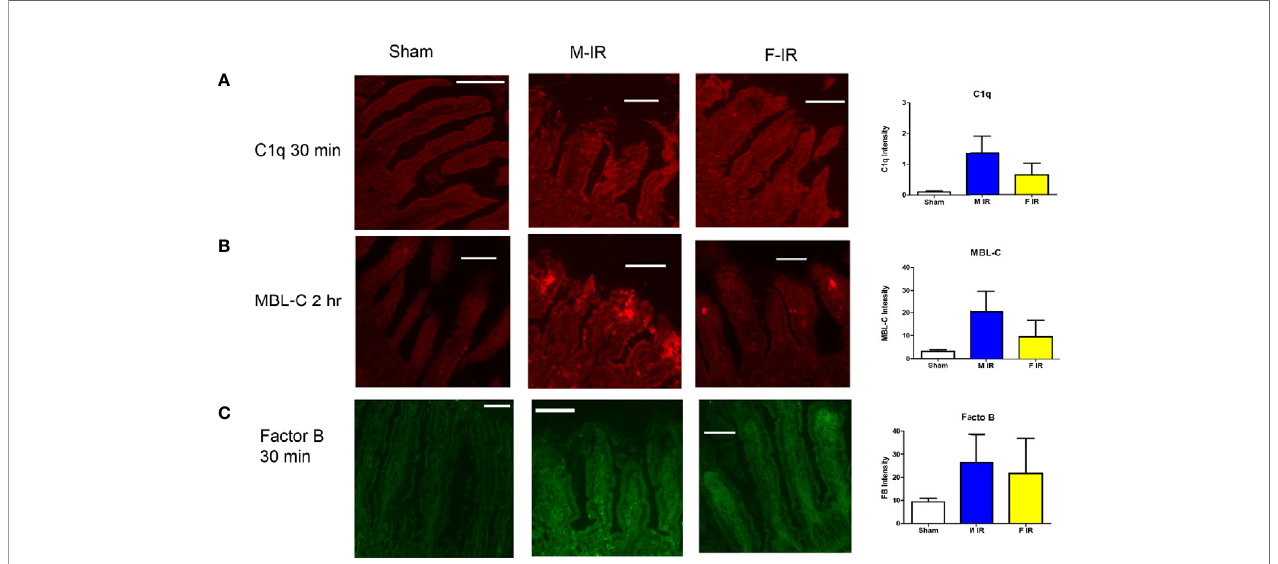
FIGURE 2 | Intestine tissue C1q, MBL-C, Factor B, deposition differs between sexes. C57B6L/J mice were subjected to Sham and IR treatment with 30 or 120 min reperfusion. Intestinal sections were stained for (A) C1q, (B) MBL-C, (C) Factor B, by immunohistochemistry. Bar = 40 µm. The image analyses for each animal were